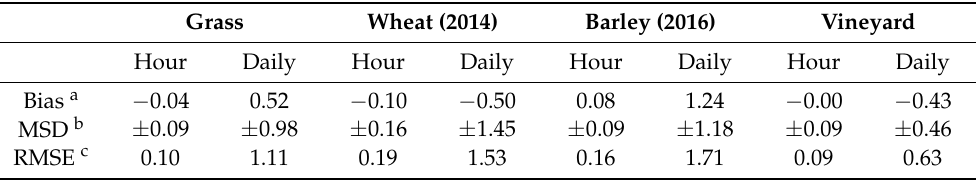
Table 3. Statistical analyses of the S-SEBI model performance with daily (mm/day) and hourly (mm/h) lysimetric data. Grass Wheat (2014) Barley (2016) Vineyard Hour Daily Hour Daily Hour Daily Hour